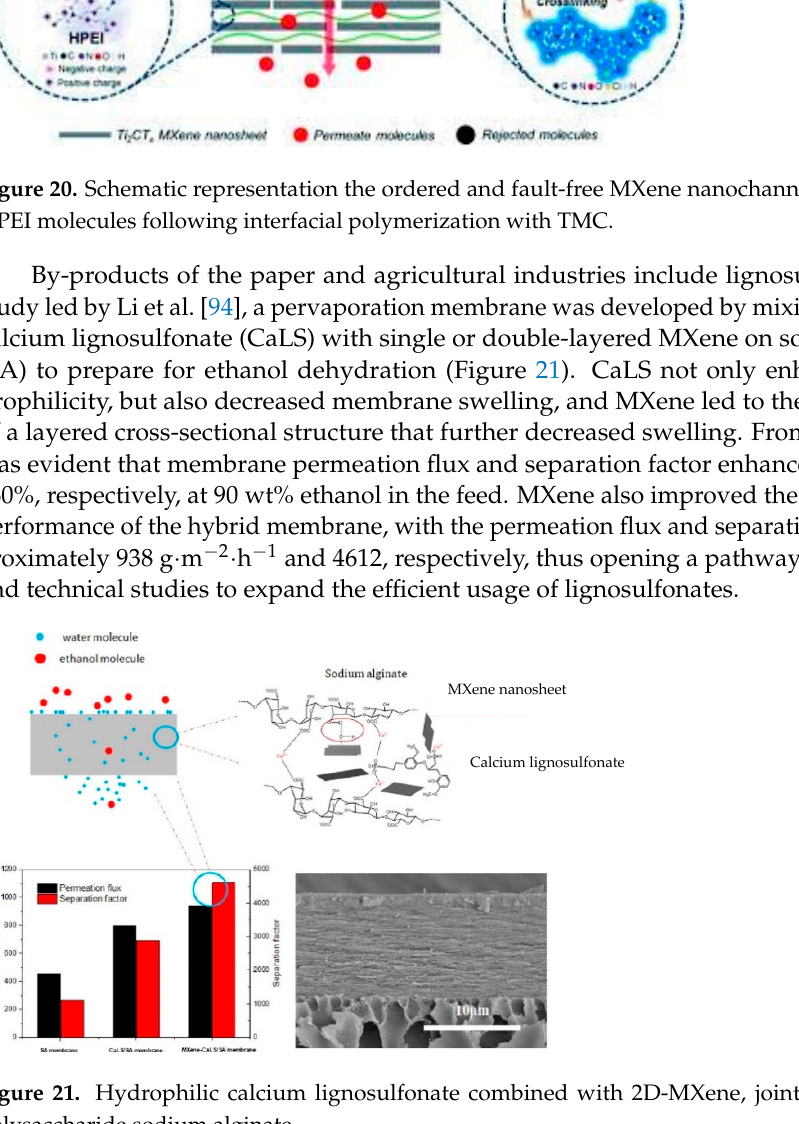
Figure 20. Schematic representation the ordered and fault-free MXene nanochannels produced by HPEI molecules following interfacial polymerization with TMC.